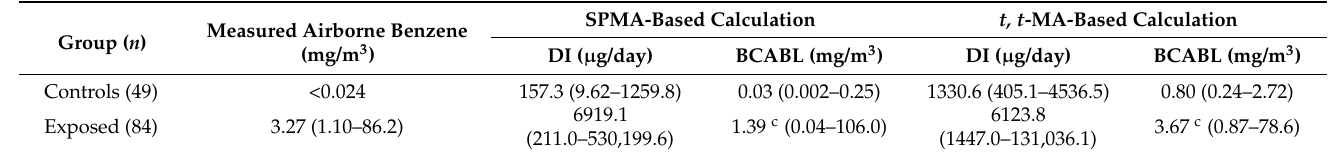
Table 3. DI a values of benzene and BCABL b based on S-PMA and t, t -MA in control and exposed